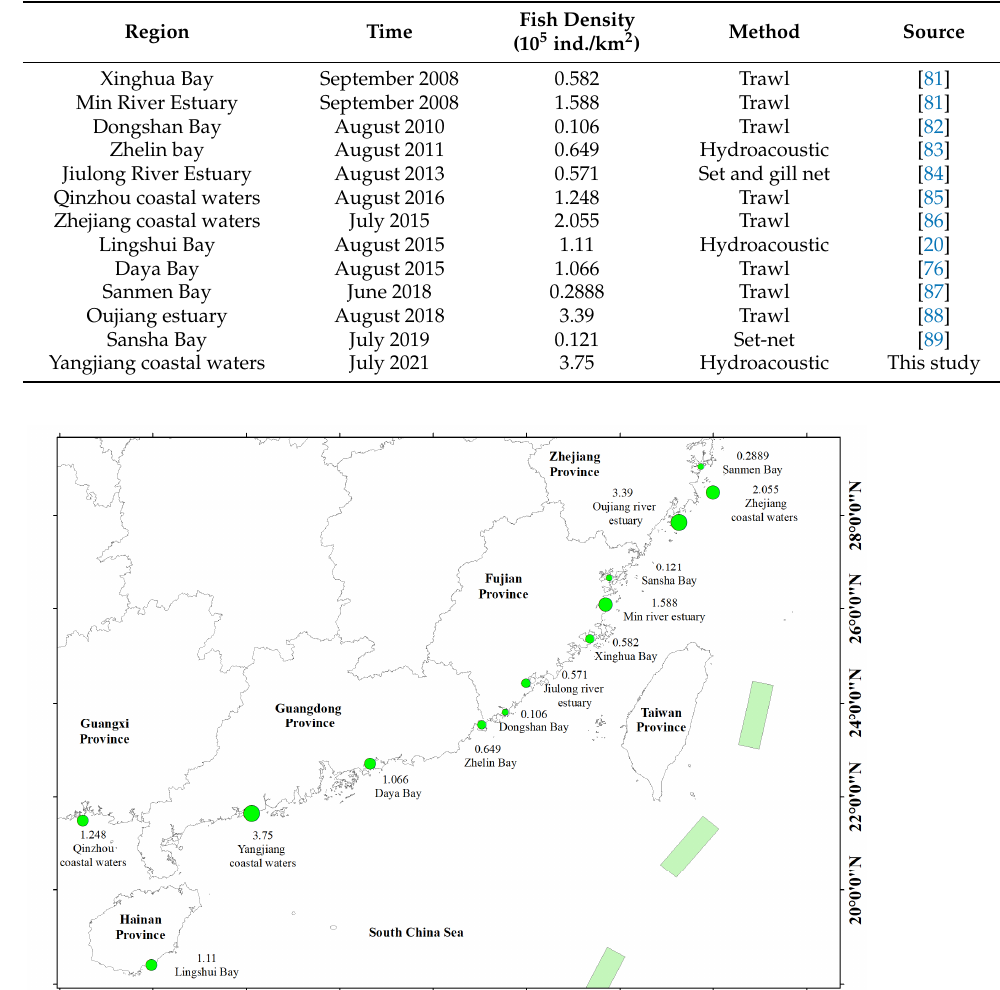
Fish Density Method Source (10 5 ind./km 2 )